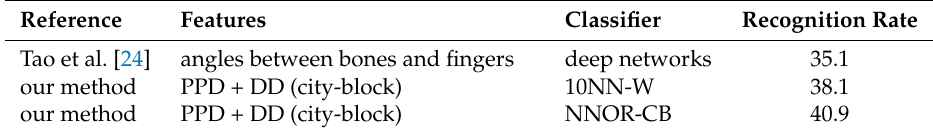
Table 7. Comparison of leave-one-subject-out, 5-fold cross-validation test results obtained for the Dataset